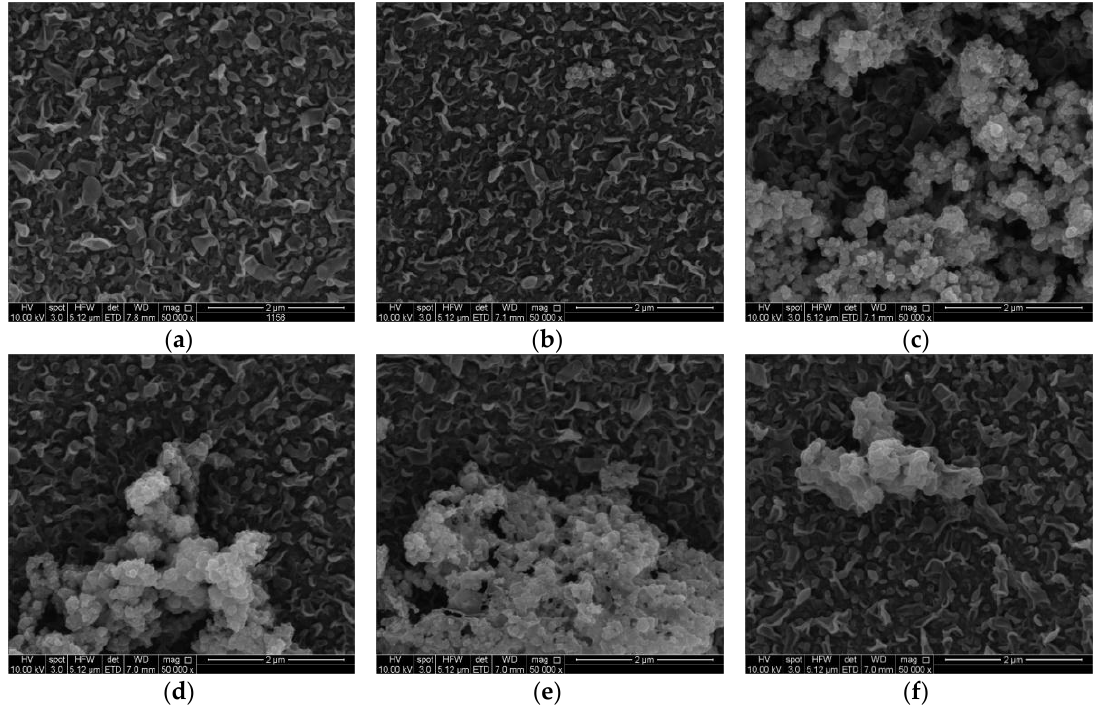
Figure 4. SEM images for membranes surface with UiO-66 NPs injection, ( a ) 0%, ( b ) 0.05%, ( c ) 0.1%, ( d ) 0.15%, ( e ) 0.2%, and ( f ) 0.3%.